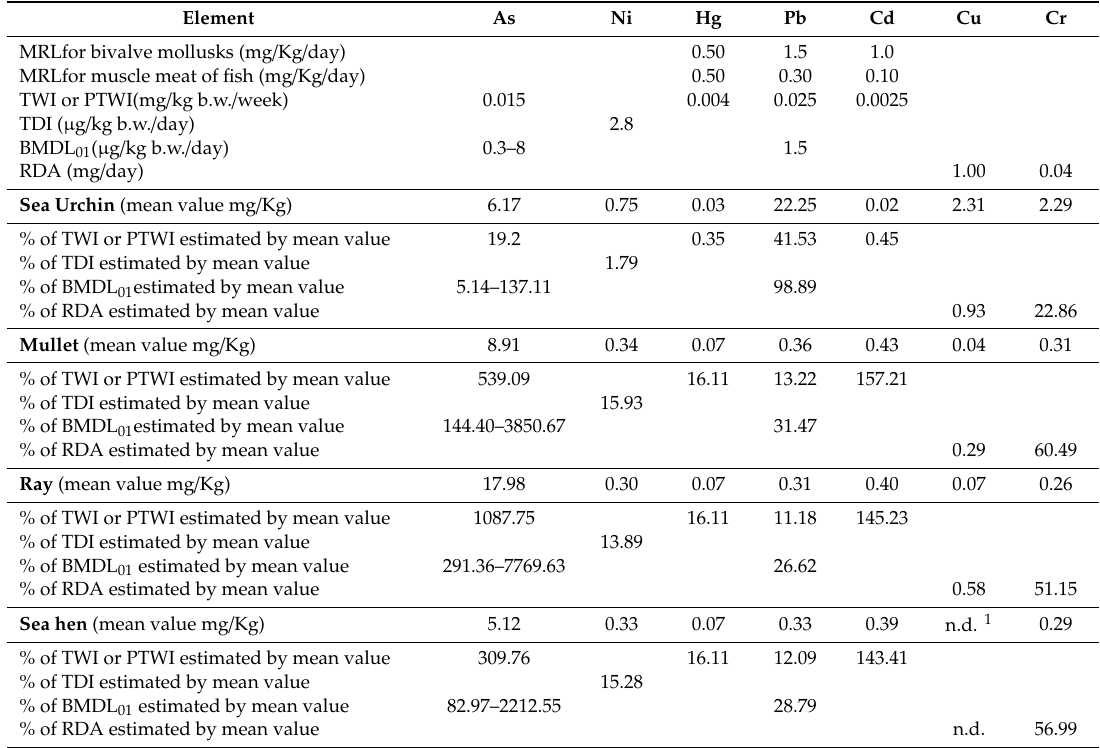
Table 8. Estimated metals intake of daily seafood consumption (4 gr of sea urchin and 77.8 gr of fish muscle) for an adult of 60